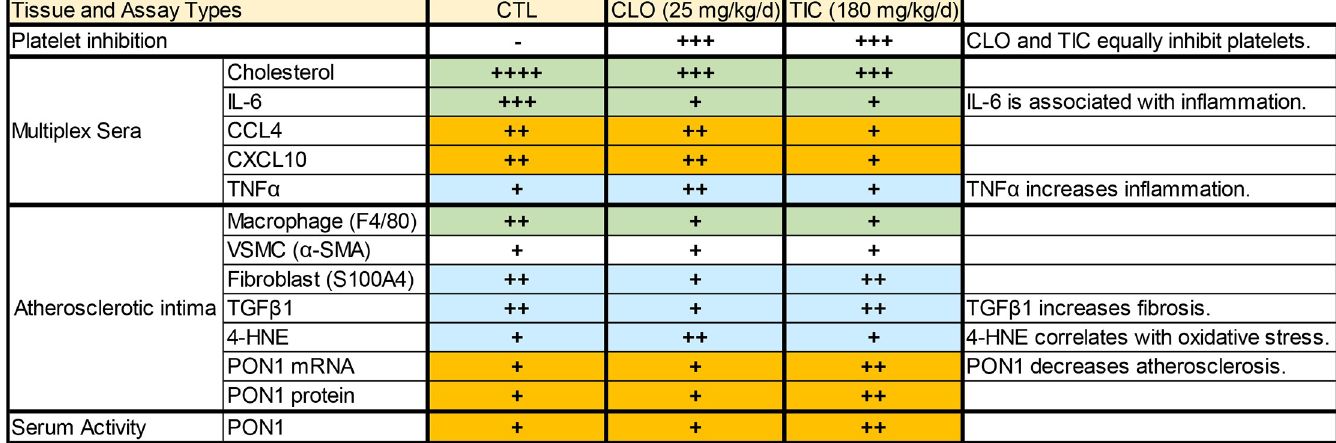
PLOS ONE | https://doi.org/10.1371/journal.pone.0218934 June 26,